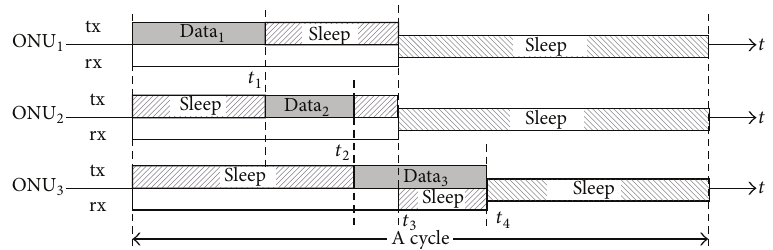
Figure 2: Sleep processes of ONUs with both upstream traffic and downstream multicast traffic.